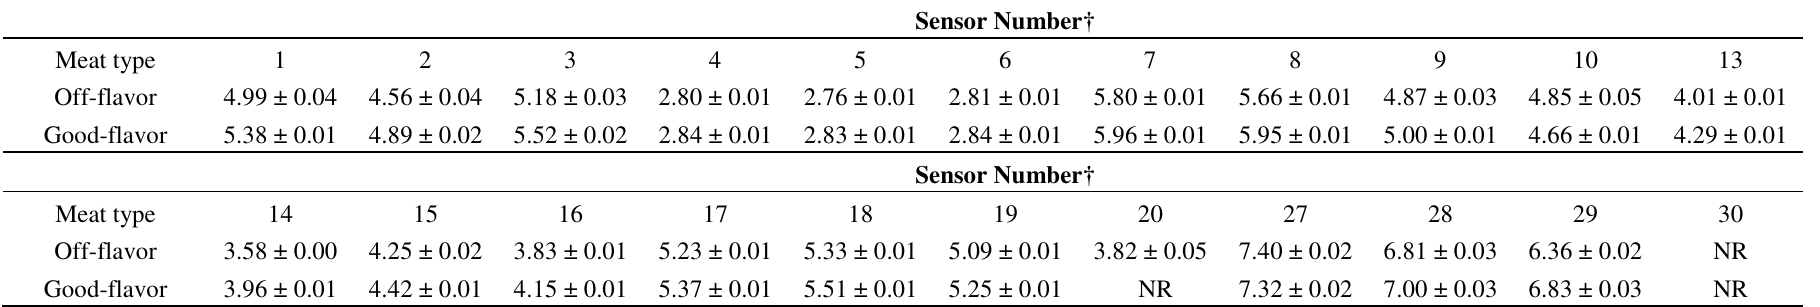
Table 1. Sensor outputs from the A32S electronic-nose sensor array comparing headspace volatiles released from meat core samples of good-flavor and off-flavor catfish based on conducting polymer (CP)